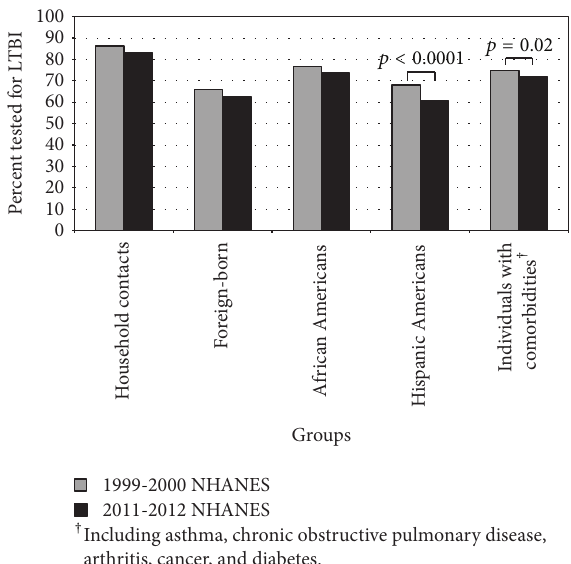
Figure 1: Change in the self-reported prevalence of latent TB infection (LTBI) testing in the United States among vulnerable groups, 1999-2000 versus 2011-2012 National Health and Nutrition Examination Surveys